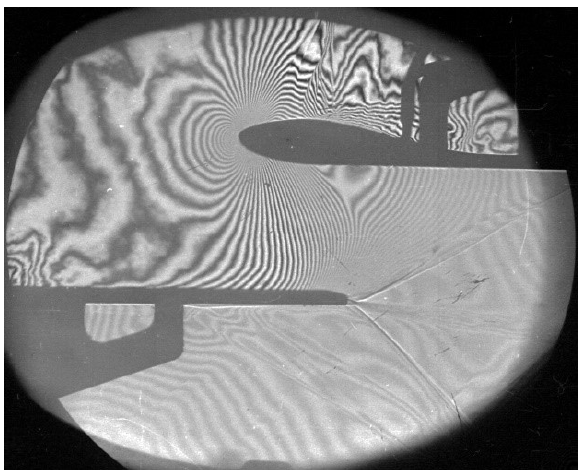
Figure 12. Tip section consisting of profiles with 2 is = the tailored trailing edge, nominal condition of flow M 2 is = 1 . 68